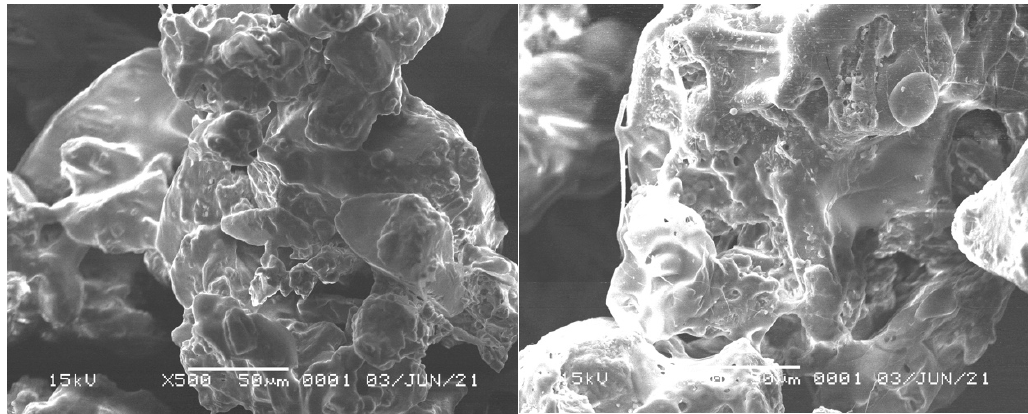
Figure 3. Morphological observation of mangosteen peel extract microcapsules.